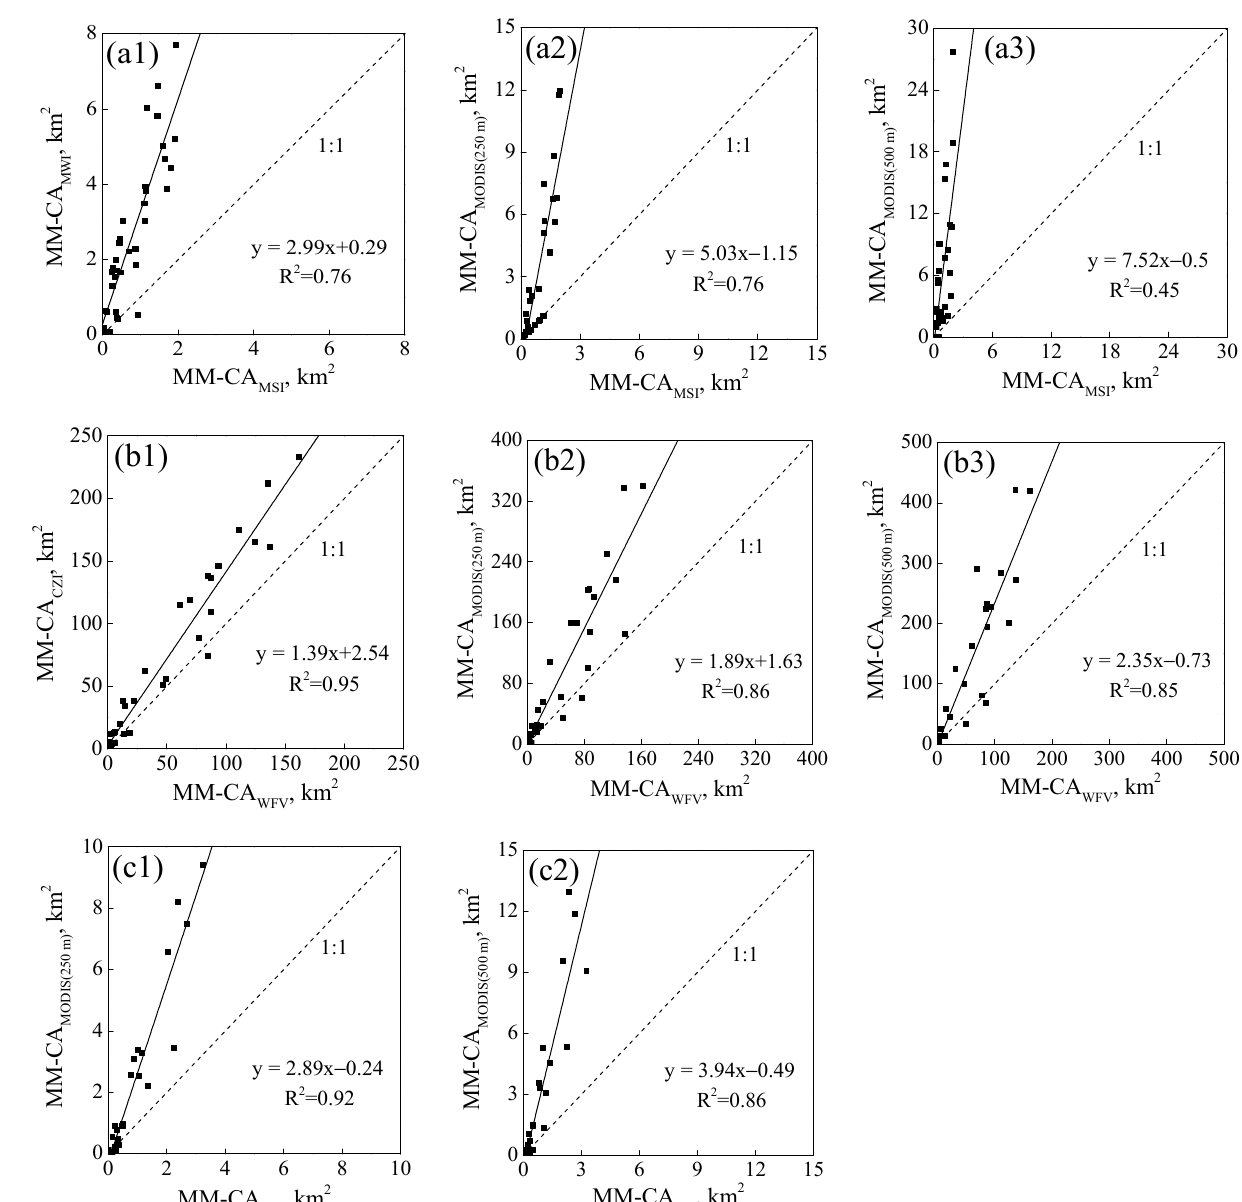
Figure 6. Relationship in the MM-CA derived from different resolution images in the subzones: ( a1 – a3 , b1 – b3 , c1 , c2 ), are corresponding to those of A2–A4, B2–B4 and C2,C3 in Table 1, respectively.